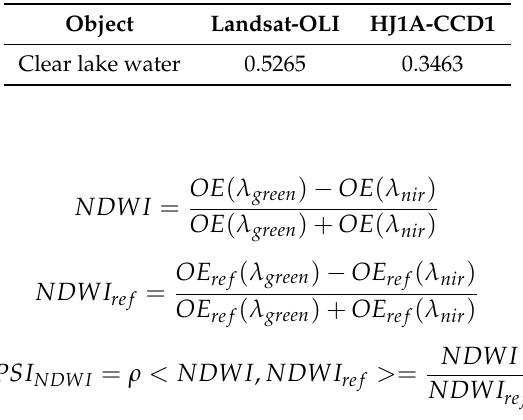
Table 8. The CPSI of natural water.